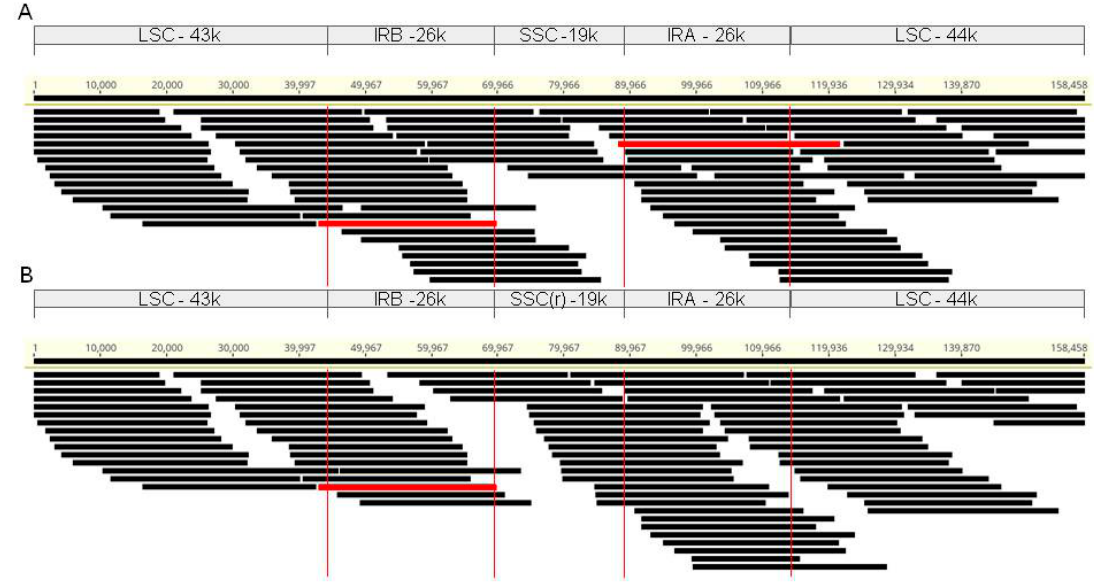
Figure 2. Confirmation of the chloroplast assembly by aligning illumina-corrected PacBio reads >25 kb onto ( A ) the chloroplast configuration inferred in this study from Bhaga (Germany) and ( B ) the configuration previously published [19] from another German individual. Long reads spanning over the inverted repeats on both sides are highlighted in red. Note that there are two reads spanning the inverted repeat regions in ( A ), confirming this orientation, while the alternate orientation lacks the necessary support by a second read spanning IRA in ( B